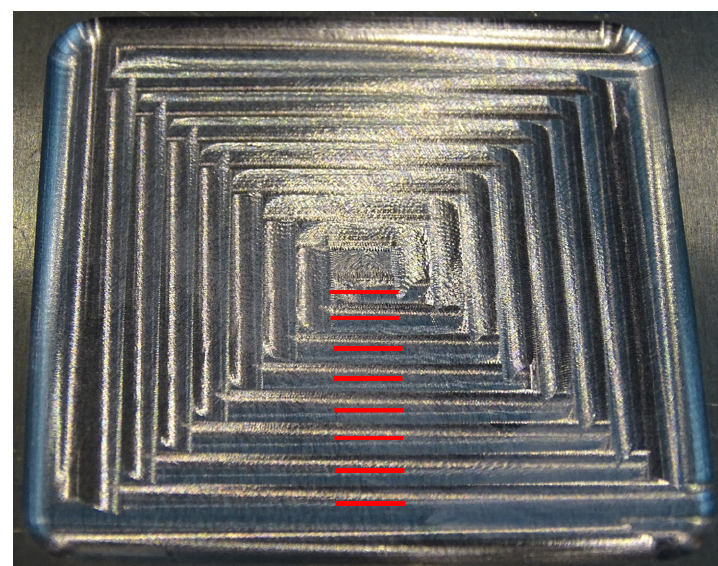
Figure 4. Roughness measurement lines.